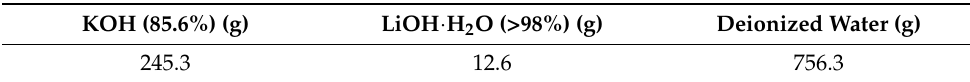
Table 4. Compositions of the alkaline solution.